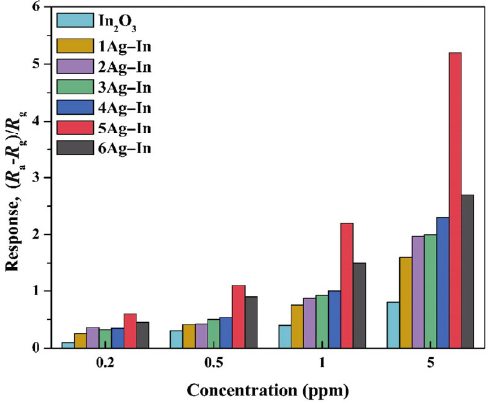
Fig. 11 Response/recovery time curves of In 2 O 3 and 5Ag–In in sensors to 0.2–5 ppm isopropanol at 300 .